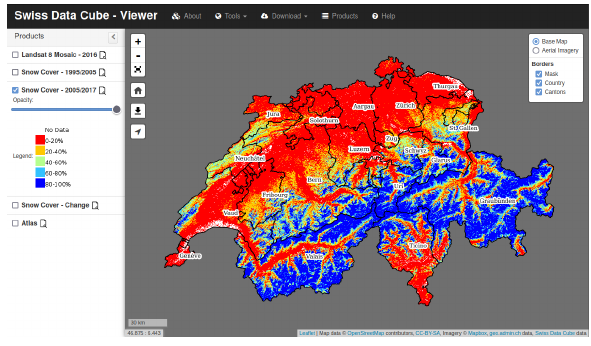
Figure 2 . The SDC ODC Explorer (Open Data Cube,